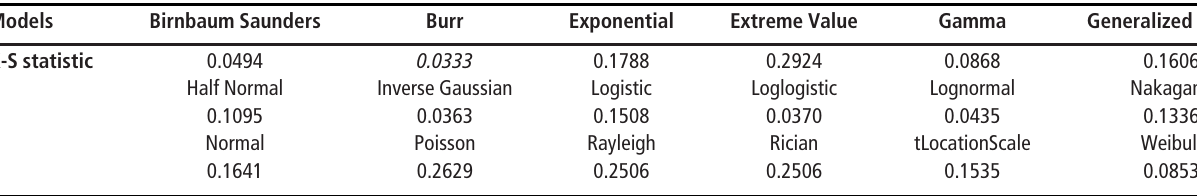
Table 1 Statistical results for different distribution models. (HighD data set) Models